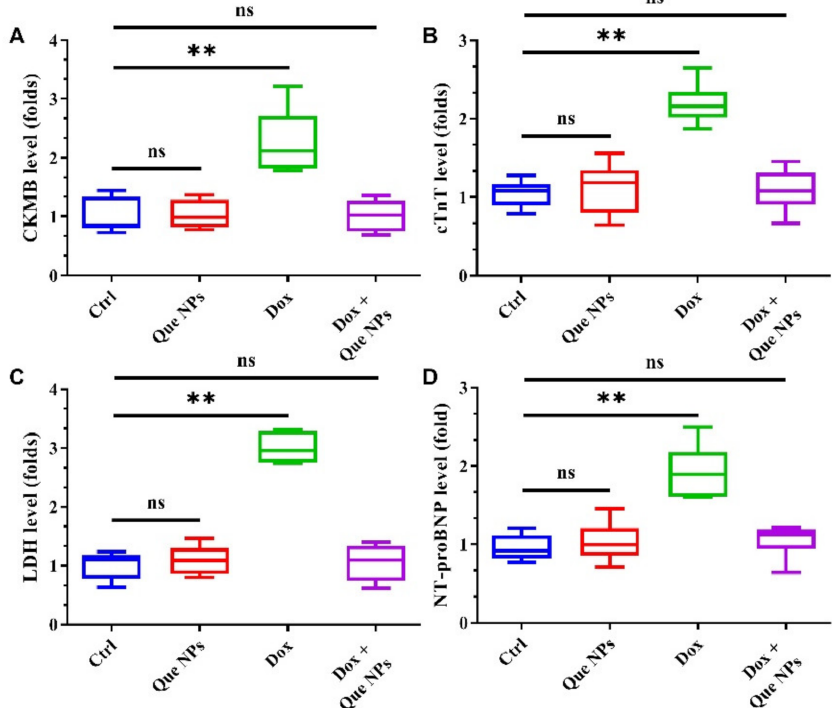
Figure 5. Cardiac injury assessment of Que NPs against cardiotoxicity induced by doxorubicin: ( A – D ) relative levels of cardiac injury protein markers CKMB ( A ), cTnT ( B ), LDH ( C ), NT-proBNP ( D ). **, p < 0.01; ns, no